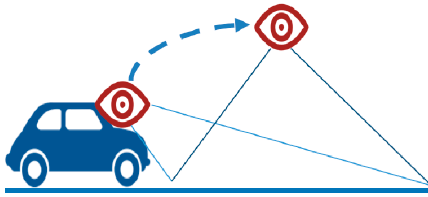
Figure 2. Inverse perspective mapping (IPM) mapping principle.